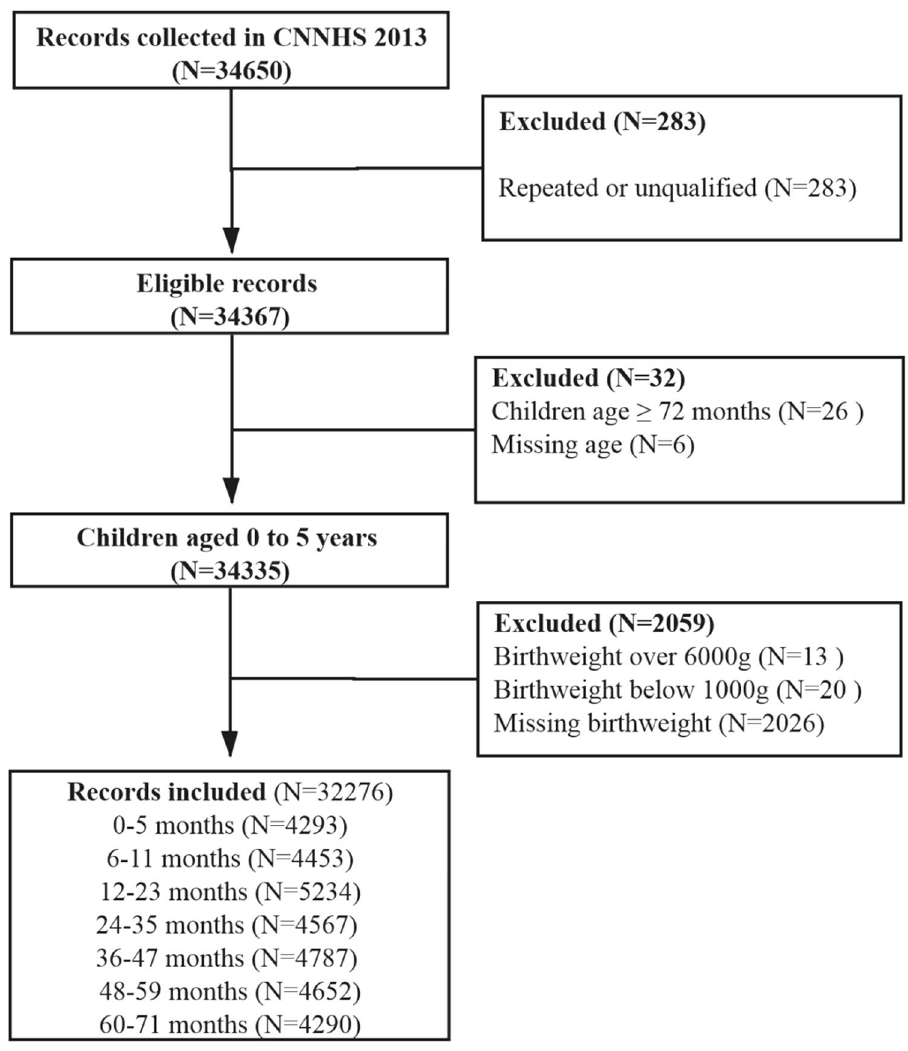
Figure 1. Flow of study